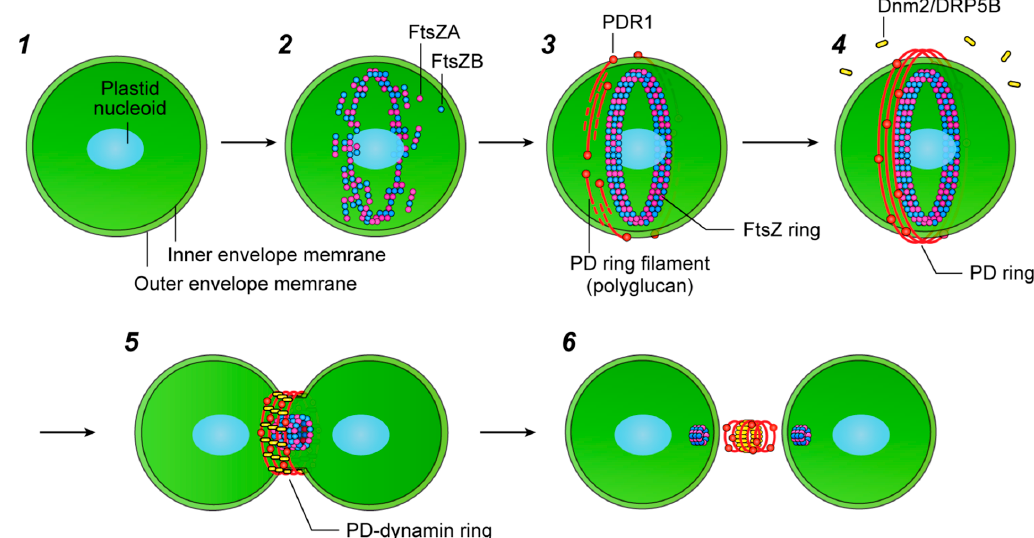
Figure 1. Representation of the plastid-division process. Plastid division occurs as follows: ( 1 , 2 ) Two types of FtsZ protein assemble in a heterodimer in the stromal region, then polymerize to form the FtsZ ring in the center of the plastid. To tether to the inner envelope membrane, FtsZ proteins bind to several membrane proteins. ( 3 , 4 ) PDR1 proteins attach to the outer envelope membrane above the site of the FtsZ ring, and it is hypothesized that PDR1 biosynthesizes polyglucan nanofilaments to form the PD ring from UDP-glucose molecules. ( 5 ) The GTPase protein Dnm2 (also known as DRP5B) binds to the PD ring filaments and is likely to generate the motive force for constriction. ( 6 ) Dnm2 proteins accumulate at the contracting bridge of two daughter plastids and pinch off the membranes. After the abscission of the plastids, the division machinery is disassembled. The inner PD ring and membrane proteins such as ARC6, and PDV2 are omitted from this representation. Modified from Yoshida et al. (2016) [21].